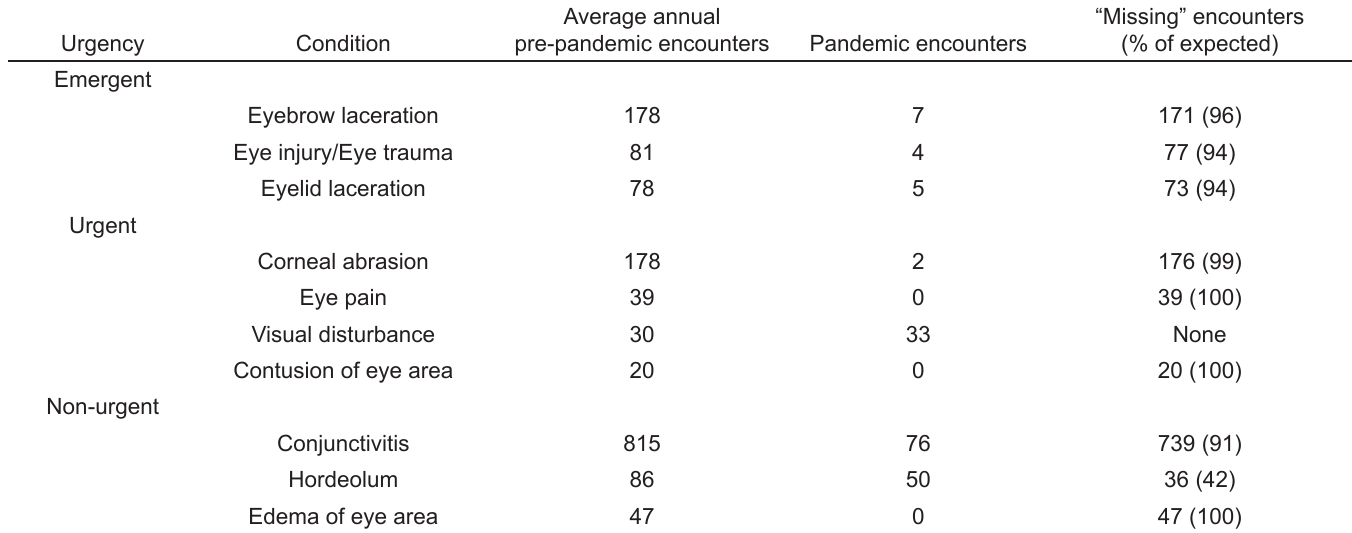
Table 5. Pediatric emergency department encounters for ocular conditions before and during the COVID-19 pandemic by urgency and